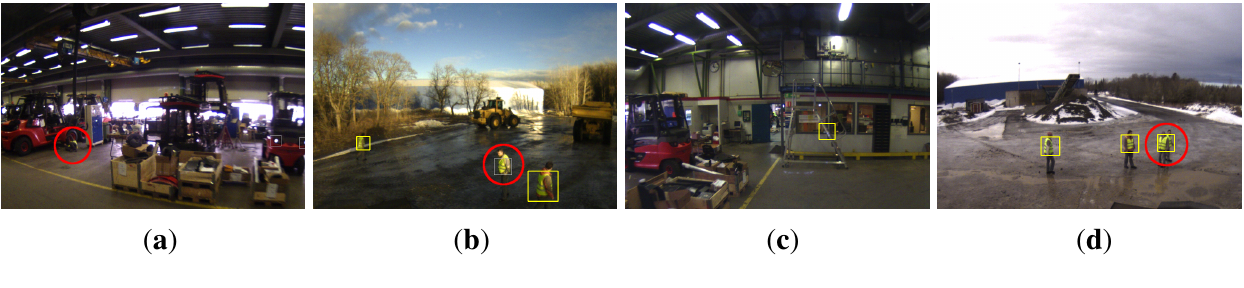
Figure 15. Erroneous tracker outputs: ( a ) missed detection of a person (marked with a red circle) in a body position that hides all reflectors of the safety clothing; ( b ) missed detection of a person that is tracked but misclassified as a non-human; ( c ) false alarms; and ( d ) occasional grouping of persons that stand close to each